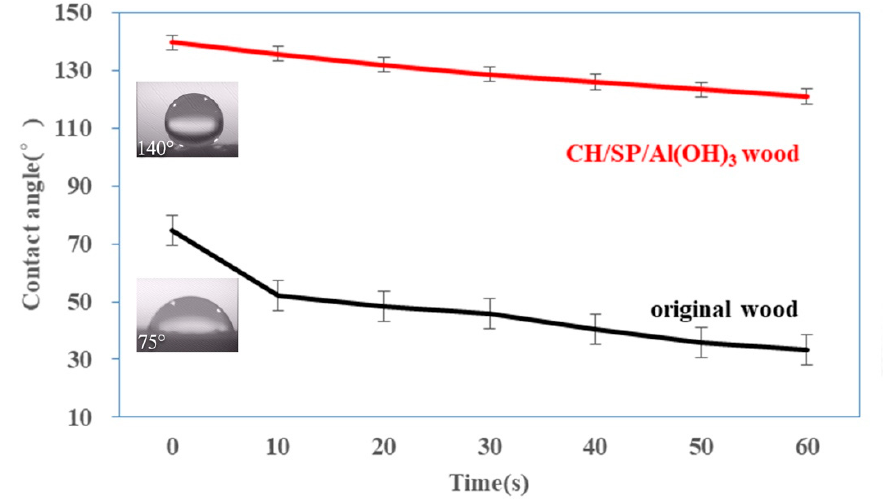
Figure 4. Water contact angles with holding time of original wood (black line) and the CH/SP/Al(OH) 3 wood (red line).